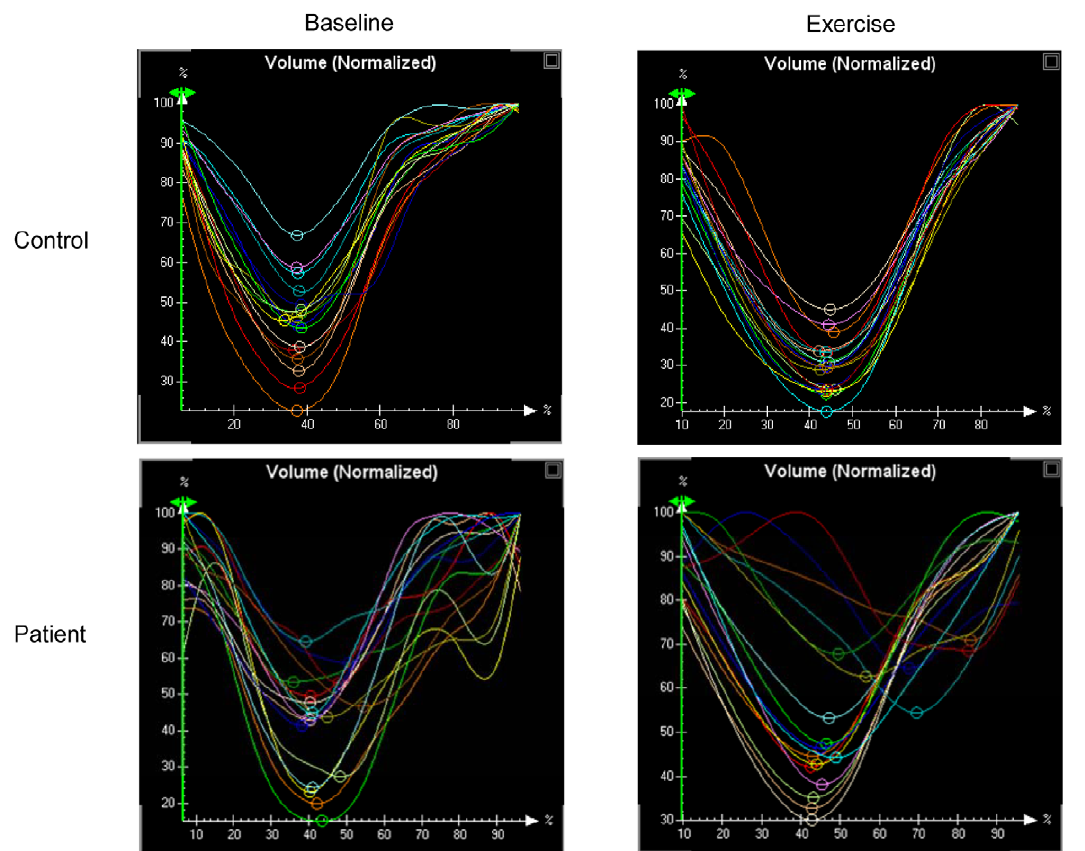
Figure 2. Regional volume curves, normalized to individual maximum, of the 16 LV segments over a cardiac cycle. The upper panels show synchronous contraction of the 16 left ventricular segments in a control at rest and during exercise, while the lower panels demonstrate dyssynchronous contraction at rest and its exaggeration during exercise in a thalassaemia patient.